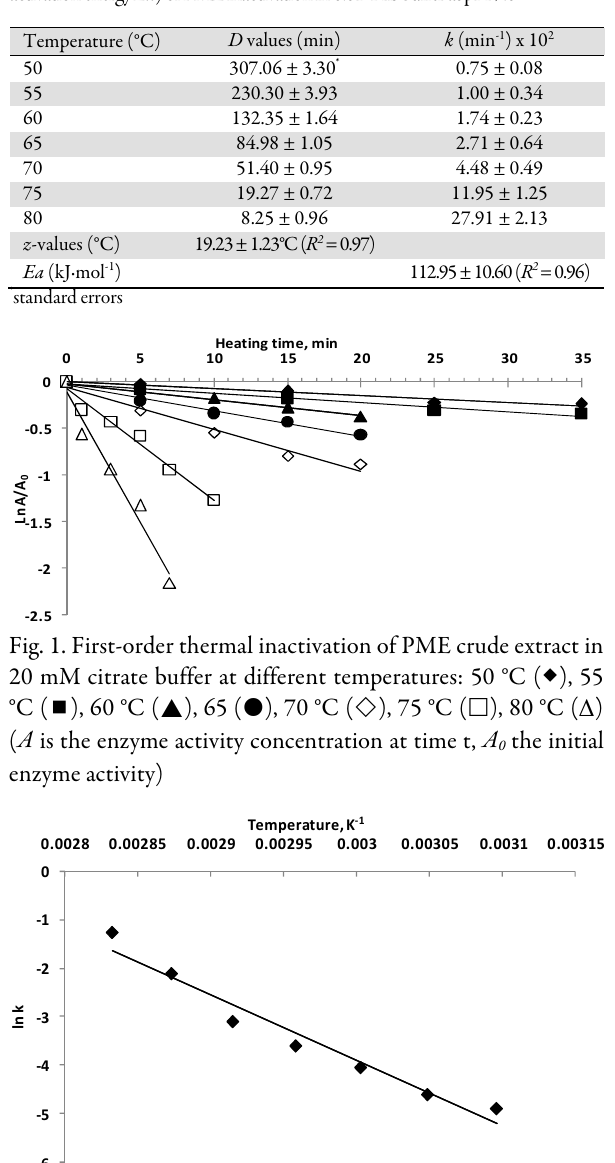
Table 1. Estimated kinetic parameters ( D -values and z , rate constant k and activation energy Ea ) of PME inactivation in 0.01 Tris buffer at pH